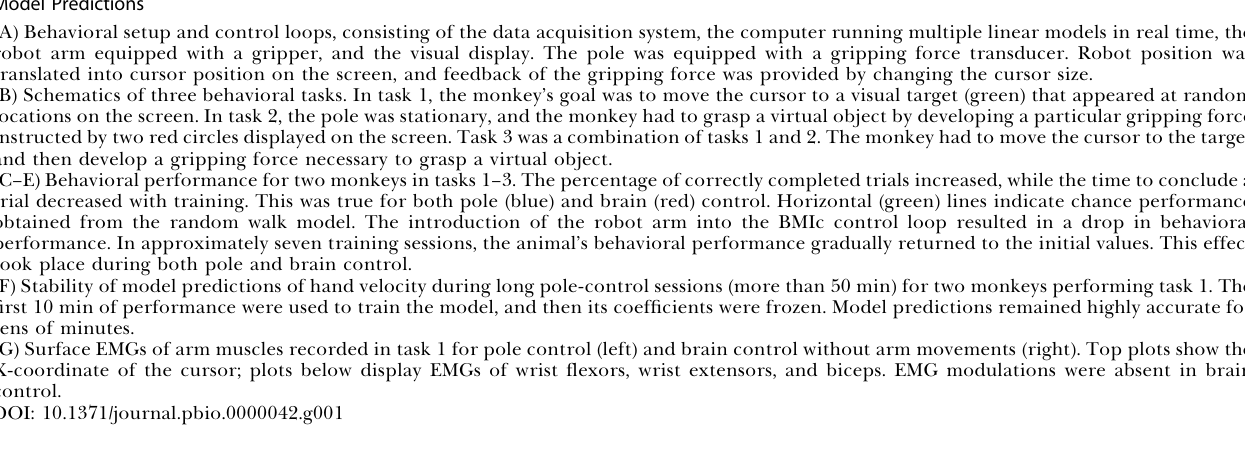
Figure 1. Experimental Setup, Behavioral Tasks, Changes in Performance with Training, EMG Records during Pole and Brain Control, and Stability of Model Predictions (A) Behavioral setup and control loops, consisting of the data acquisition system, the computer running multiple linear models in real time, the robot arm equipped with a gripper, and the visual display. The pole was equipped with a gripping force transducer. Robot position was translated into cursor position on the screen, and feedback of the gripping force was provided by changing the cursor size. (B) Schematics of three behavioral tasks. In task 1, the monkey’s goal was to move the cursor to a visual target (green) that appeared at random locations on the screen. In task 2, the pole was stationary, and the monkey had to grasp a virtual object by developing a particular gripping force instructed by two red circles displayed on the screen. Task 3 was a combination of tasks 1 and 2. The monkey had to move the cursor to the target and then develop a gripping force necessary to grasp a virtual object. (C–E) Behavioral performance for two monkeys in tasks 1–3. The percentage of correctly completed trials increased, while the time to conclude a trial decreased with training. This was true for both pole (blue) and brain (red) control. Horizontal (green) lines indicate chance performance obtained from the random walk model. The introduction of the robot arm into the BMIc control loop resulted in a drop in behavioral performance. In approximately seven training sessions, the animal’s behavioral performance gradually returned to the initial values. This effect took place during both pole and brain control. (F) Stability of model predictions of hand velocity during long pole-control sessions (more than 50 min) for two monkeys performing task 1. The first 10 min of performance were used to train the model, and then its coefficients were frozen. Model predictions remained highly accurate for tens of minutes. (G) Surface EMGs of arm muscles recorded in task 1 for pole control (left) and brain control without arm movements (right). Top plots show the X-coordinate of the cursor; plots below display EMGs of wrist flexors, wrist extensors, and biceps. EMG modulations were absent in